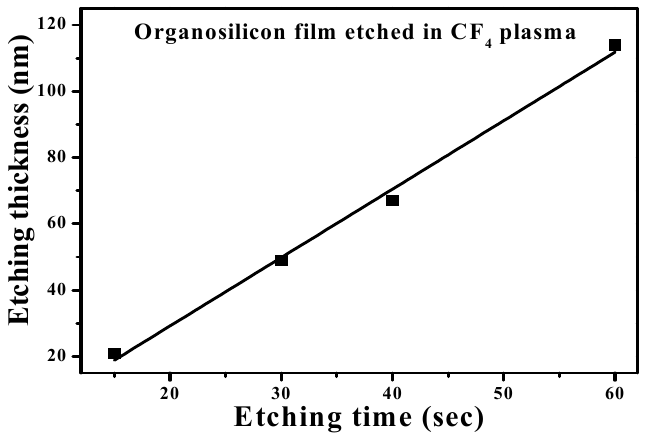
Figure 7. Etching thickness of the organosilicon film treated by the CF 4 plasma as a function of the etching time.